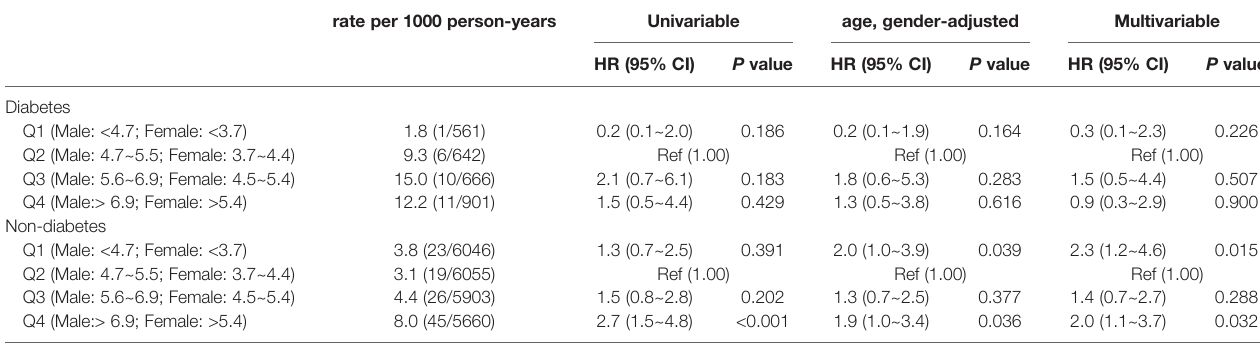
TABLE 3 | Hazard ratios of SUA levels for all-cause mortality among individuals with and without diabetes. rate per 1000 person-years